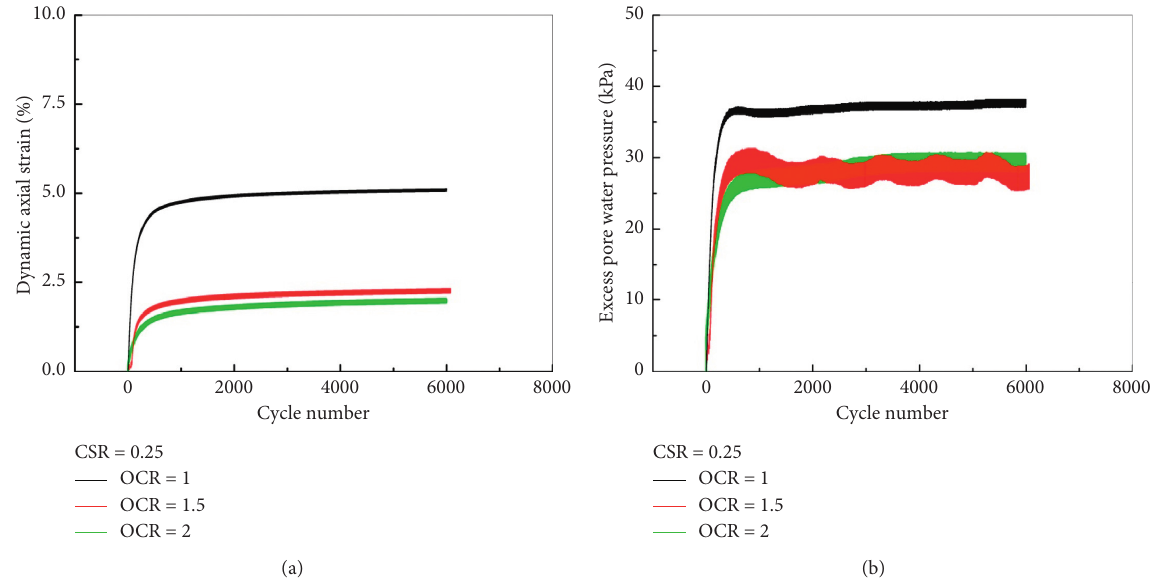
Figure 7: Dynamic response of soil specimen at different OCR: (a) dynamic axial strain; (b) excess pore water pressure.